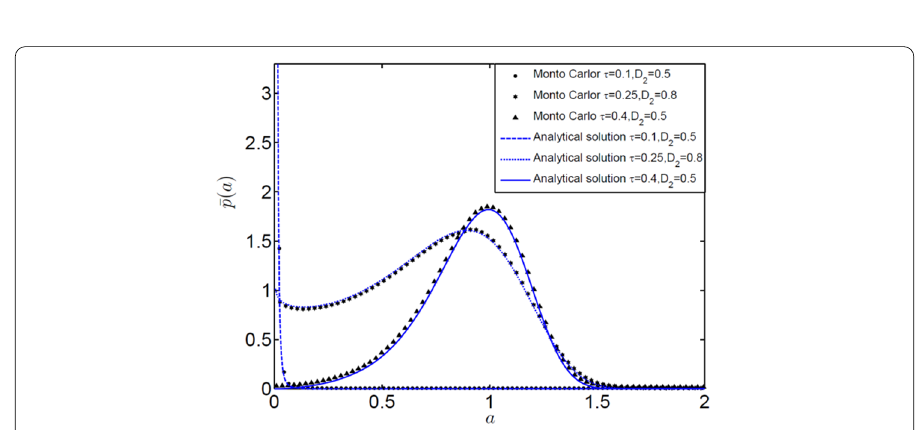
Figure 14 Transition set curves under multiplicative noise excitation (taking τ and D 2 as unfolding parameters)